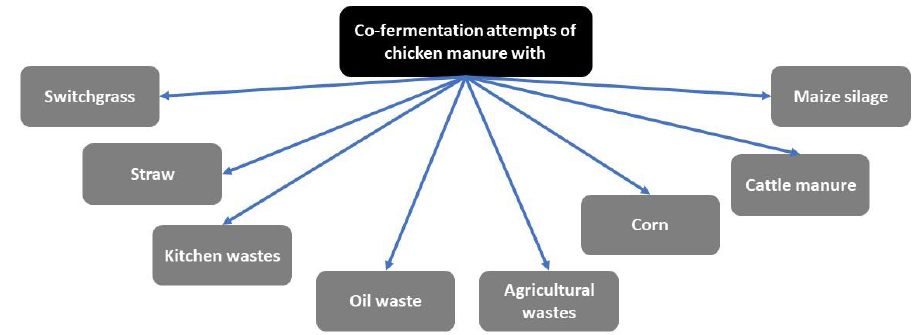
Figure 10. Attempts to conduct chicken manure co-fermentation with different substrates under dry AD. Ahn et al. [95] investigated batch chicken manure co-fermentation with switchgrass (Panicum virgatum) in a ratio of approximately 1:2 with a TS concentration up to 16%, at a temperature of 55 There was inhibition of methane production at ammonium and VFA concentrations of 15 and 9.4 g / L, respectively, at a pH of 5.5. The methane yield was 2 mL / g